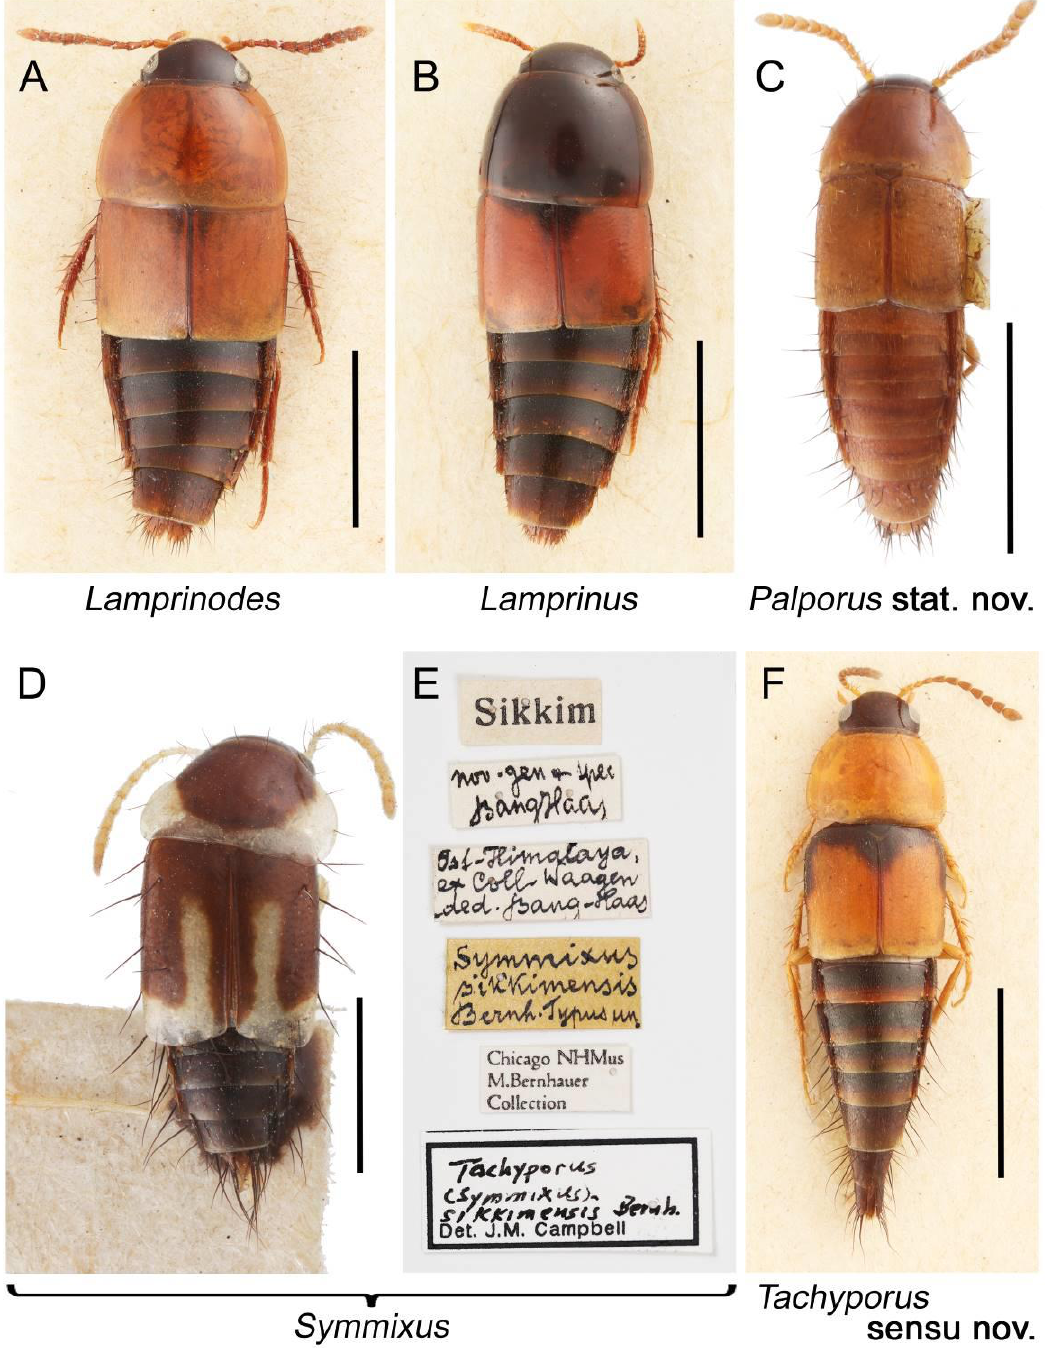
Figure 6. Habitus photographs of Tachyporini: Tachyporina, dorsal view. ( A ) Lamprinodes saginatus (Gravenhorst). ( B ) Lamprinus erythropterus (Panzer). ( C ) Palporus nitidulus . ( D ) Symmixus sikkimensis , holotype. ( E ) holotype labels of Symmixus sikkimensis . ( F ) Tachyporus chrysomelinus . Scale bars: 1.5 mm ( A , B , F ); 1.0 mm ( C , D